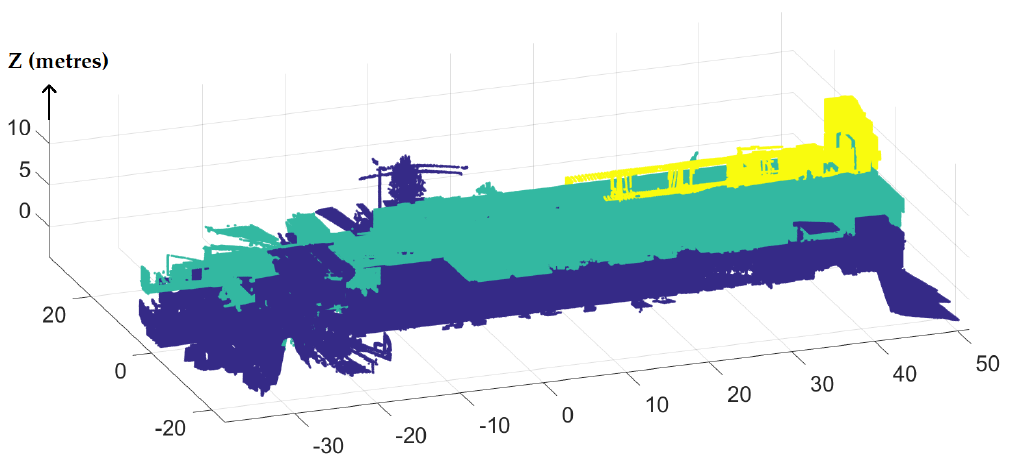
Figure 3. Floor segmentation result—3 floors of the INSA building (one colour per